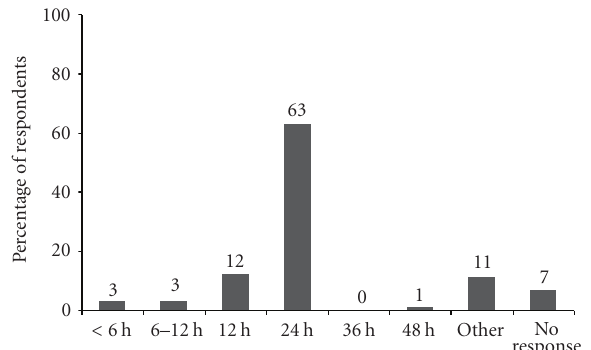
Figure 3: Duration of Post-Cesarean Delivery Monitoring for Respiratory Depression.